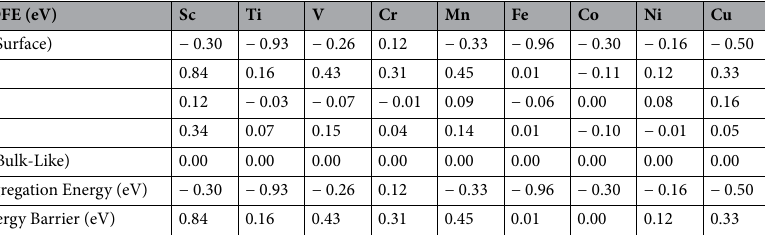
Table 2. Relative defect formation energy for the considered dopants at positions 1–5 in the slab (see Fig. 1).